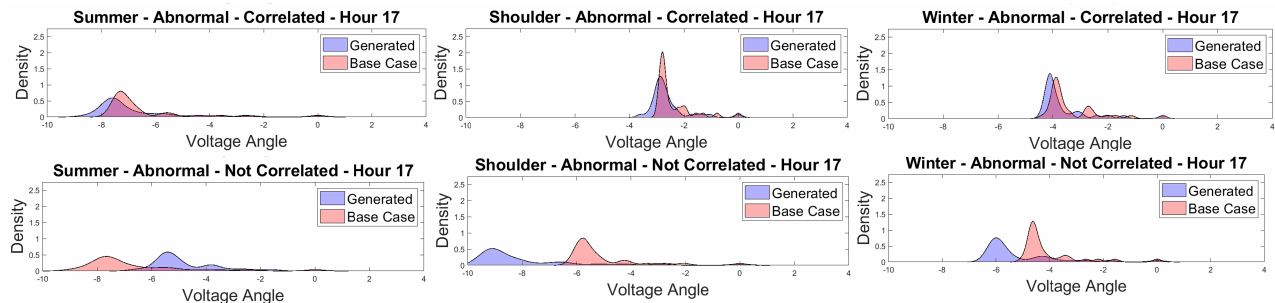
Figure 12. Voltage angle PDFs − abnormal, all seasons.